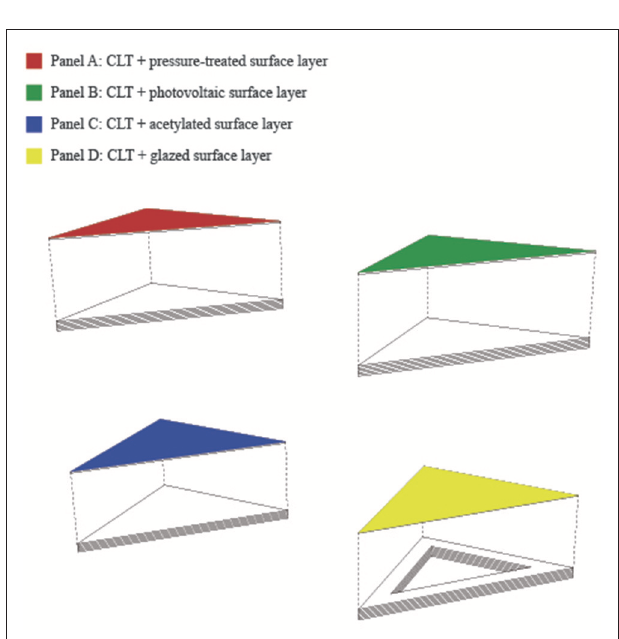
FIGURE 3 | The four CLT-based building elements used in the